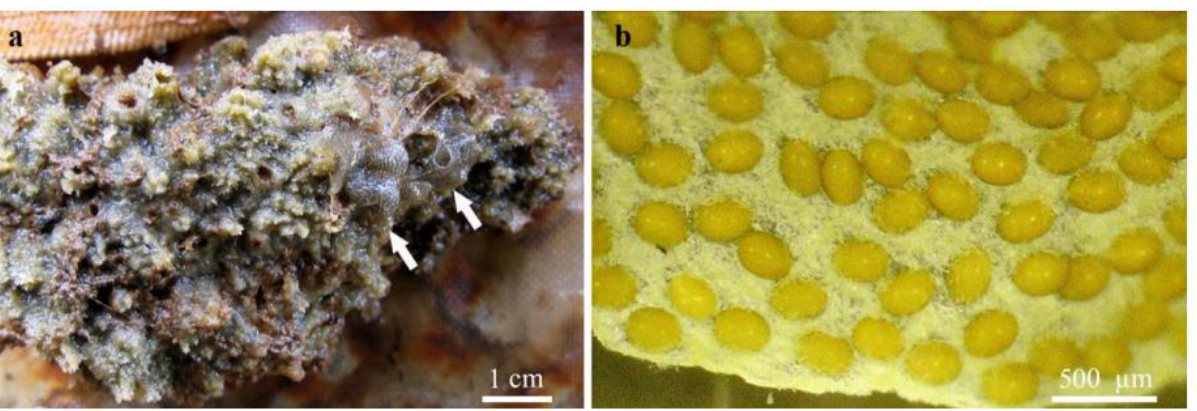
Figure 5. Sponge-dwelling caddisfly and non-biting midge larvae recycling siliceous spicules of Corvospongilla siamensis (Lower Mekong, Southeast Asia). ( a , b ) Pupae case of spongivorous Amphipsyche meridiana (Trichoptera, Hydropsychidae) reinforced by megascleres and microscleres (arrows, SEM) adhering to the silk network of the inner and outer cases. ( c , d ) Case of a chironomid larva (Chironomidae, Diptera) with a dense network of spicules (arrow, LM).